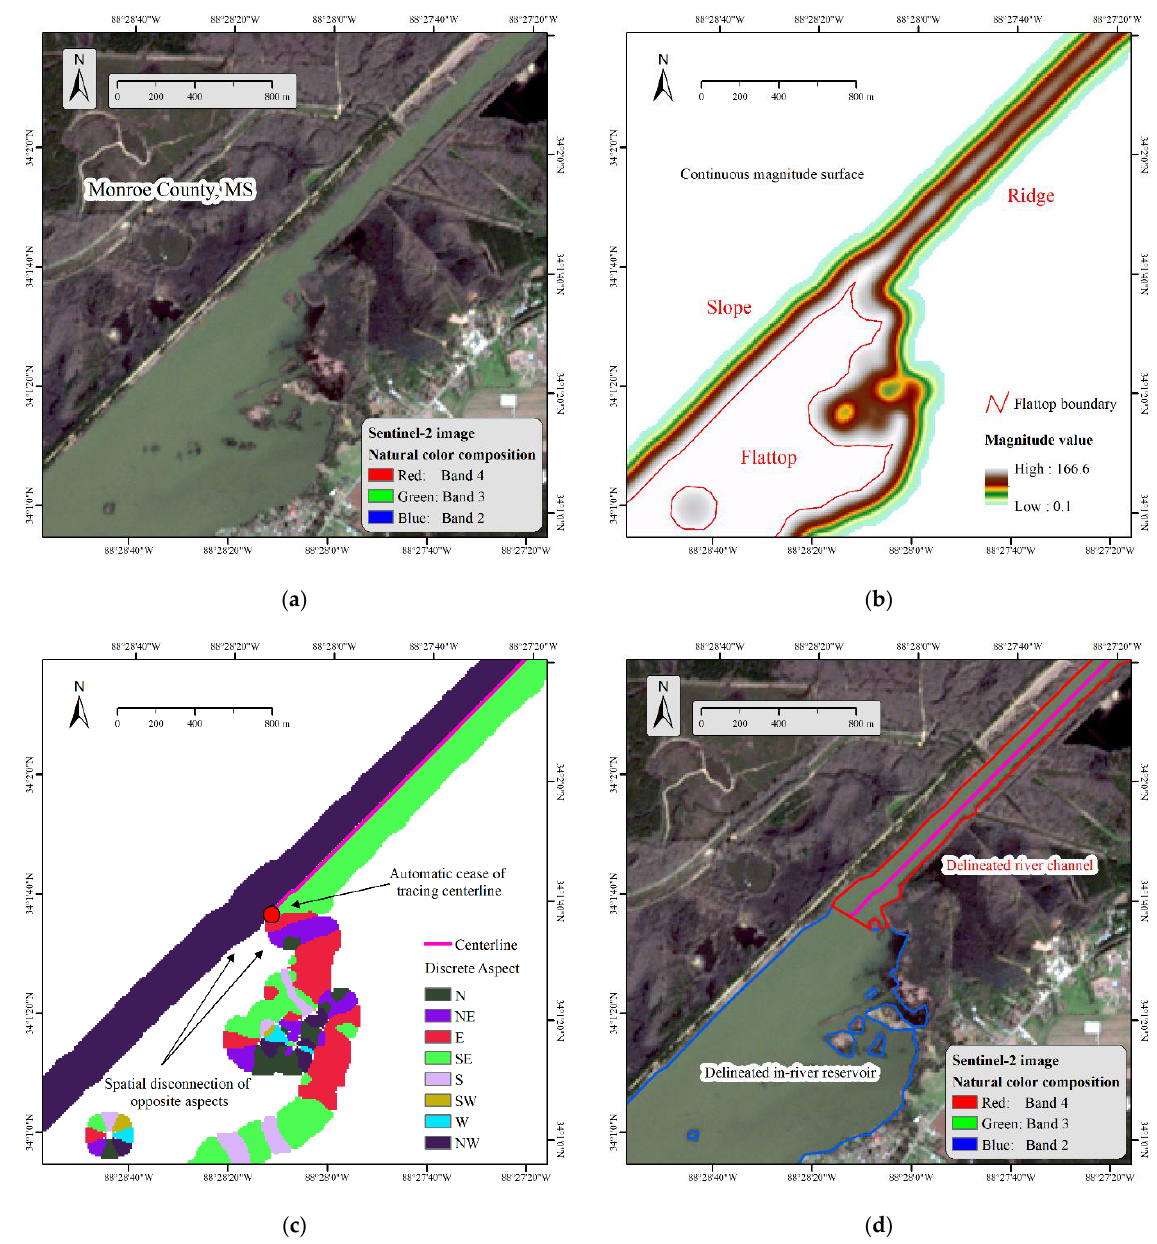
Figure 7. The function of small kernel size and the automatic separation of the river channel and in-river reservoir: ( a ) a reservoir connected with a channel; ( b ) the magnitude surface and a flattop of saturated magnitude values; ( c ) the automatic cease of tracing centerline due to the spatial disconnection of opposite aspects; and ( d ) the separation of the river channel and in-river reservoir using the delineated river channel centerline.